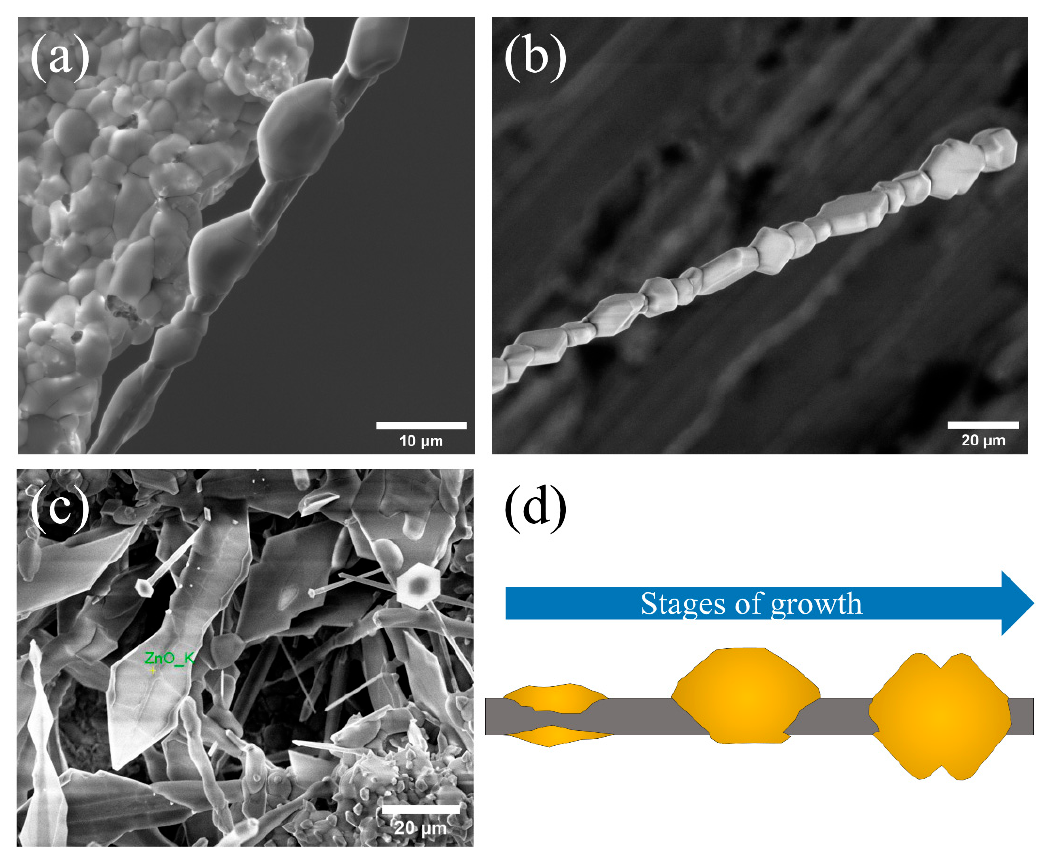
Figure 3. Characteristic morphologies observed on the surface of a pellet. ( a ) Quasi-periodic mor- phology that grows from a central thread. ( b ) Central thread coated with faceted structures. The orientation of each structure rotates 90° periodically (approximately every 30 µm). ( c ) Triangular structures. ( d ) Outline of how the growth of structures in ( a ) and ( b ) could occur.